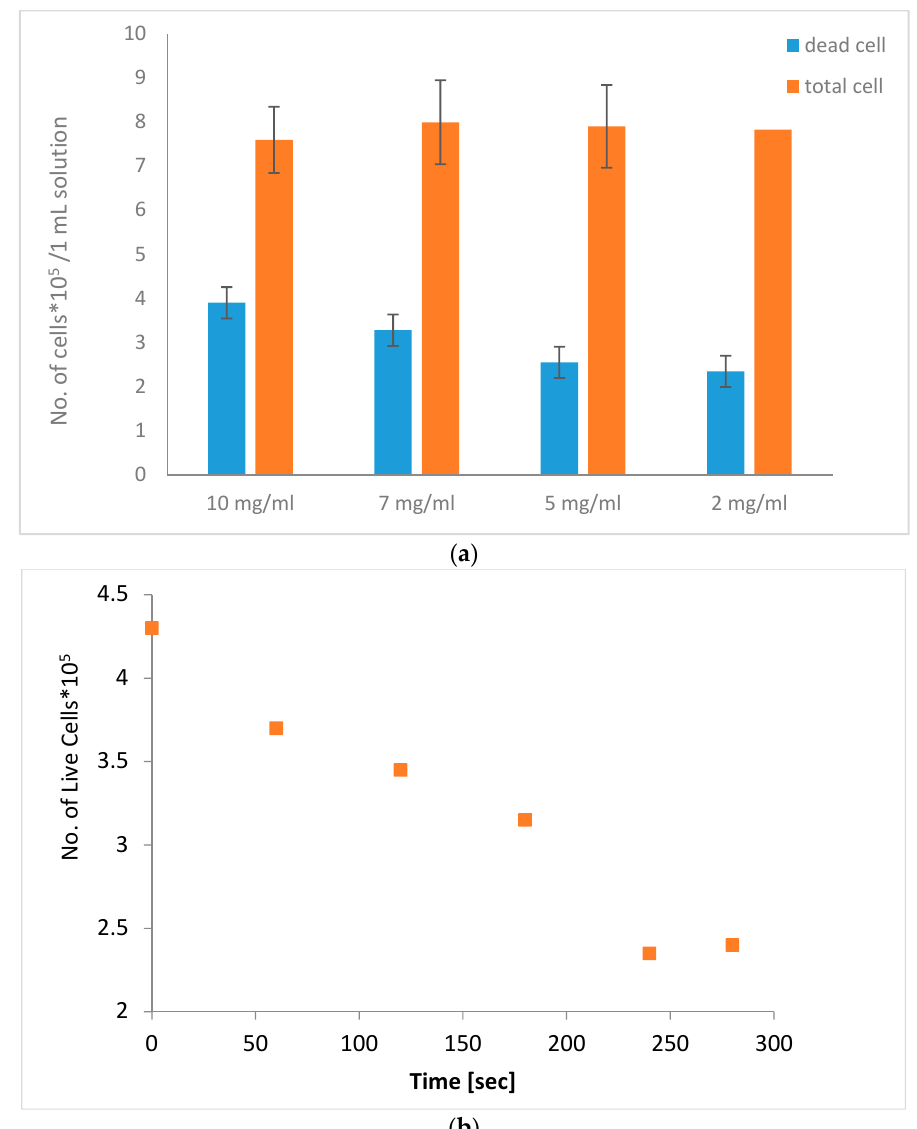
Figure 4. Number of cells in a 1 mL solution after AMF treatment for 5 min ( a ) with different particle concentrations (2 mg/mL–10 mg/mL); ( b ) The number of live cells in a sample with 10 mg/mL particles over a 5 min treatment.